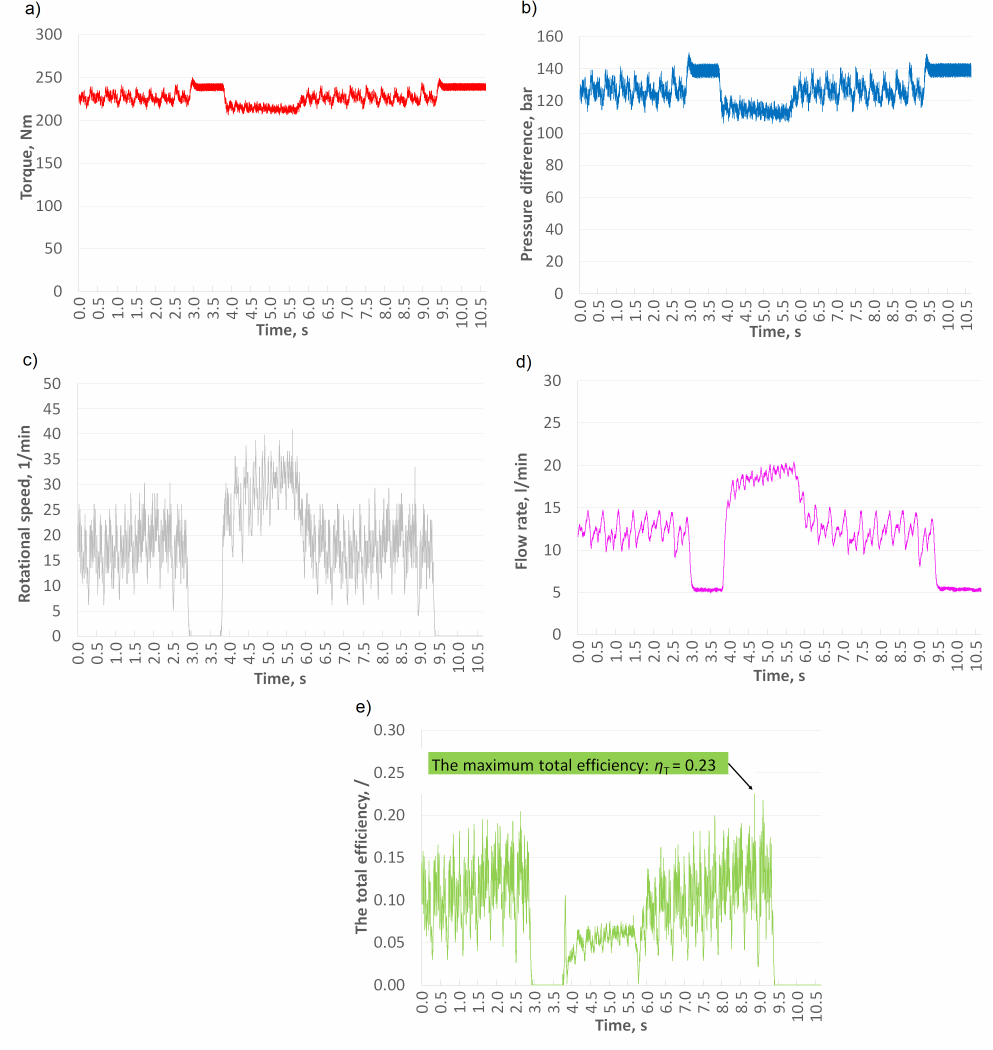
Figure 13. Experimental results of the modified hydraulic motor: ( a ) torque, ( b ) pressure difference, ( c ) rotational speed, ( d ) flow rate, and ( e ) total